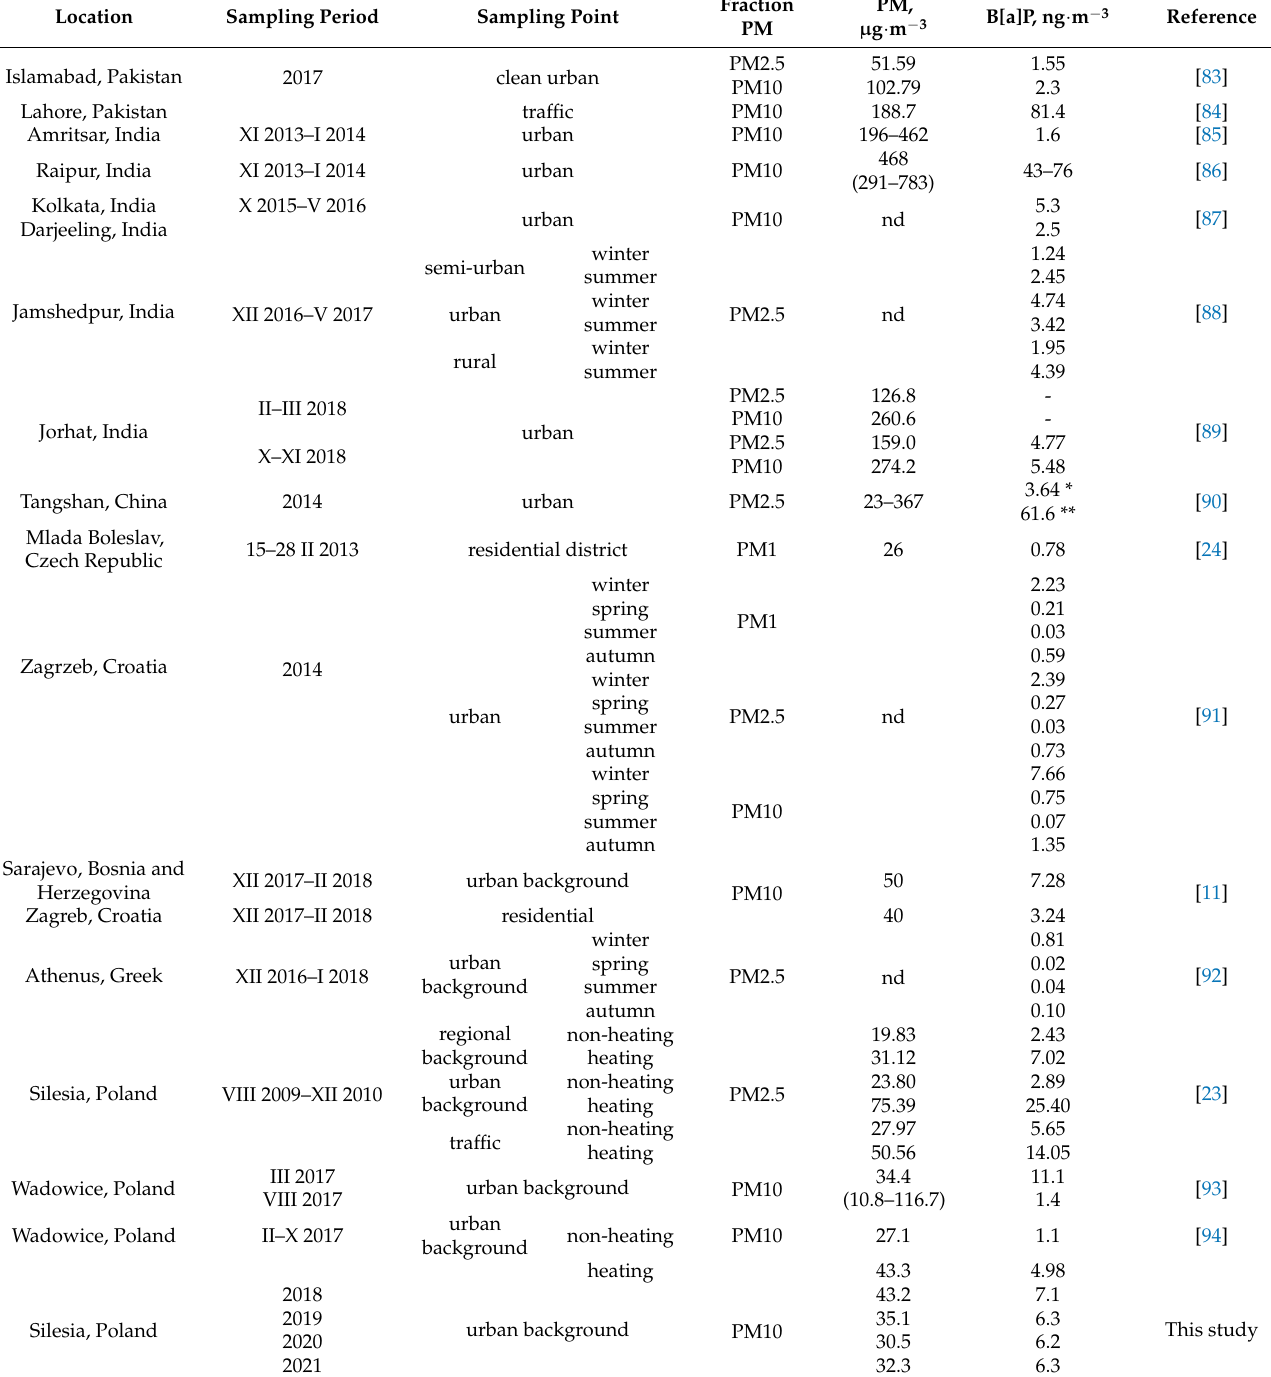
Table 3. Comparisons of concentrations of PM and PM-bound B[a]P at various